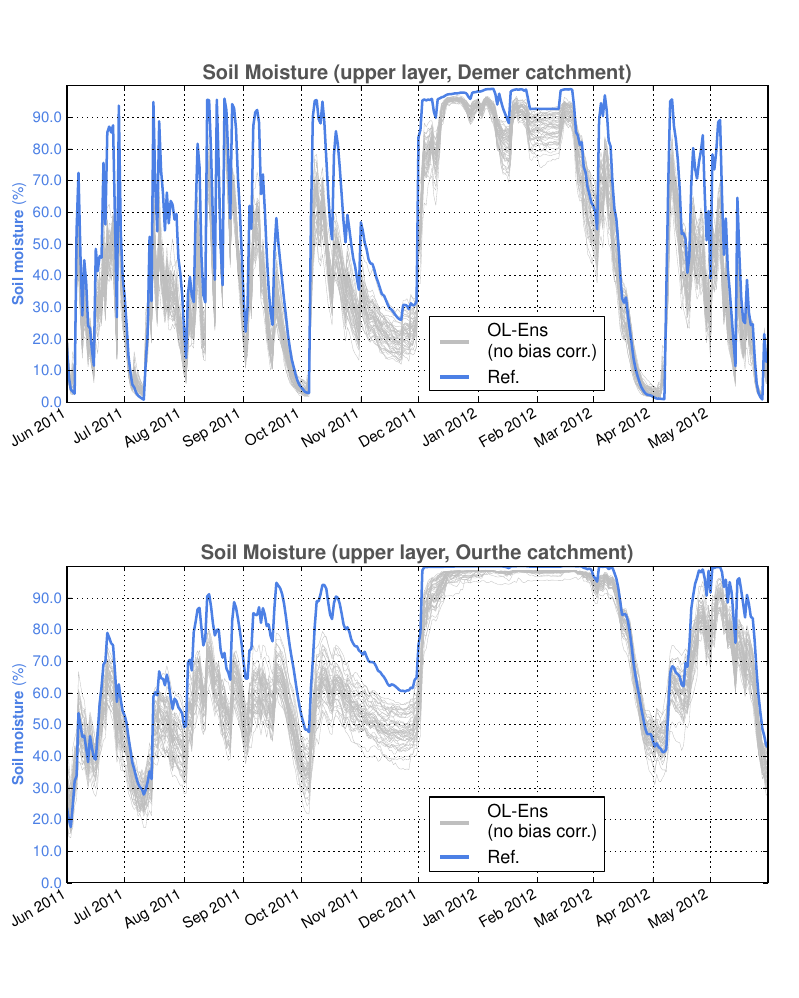
Figure 4. Spatially averaged SSM over the Demer and the Ourthe catchments. The reference simulation obtained with the deterministic SCHEME model run and the original open loop ensembles (OL-Ens) are depicted (June 2011–May 2012).